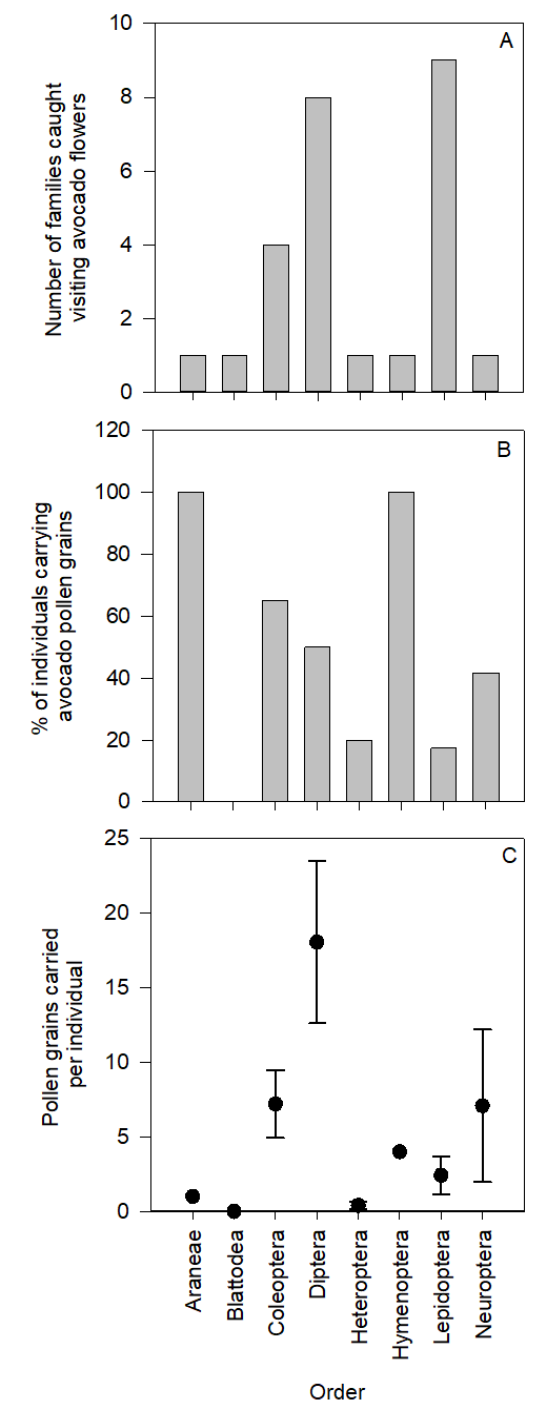
F IGURE 5: Summary of arthropod flower visitors caught while visiting open ‘Hass’ avocado flowers at night, showing the number of families of arthropods caught in each order (A), the percentage of individuals of each order that were found to be carrying avocado pollen grains (B), and the mean (+/-SEM) number of pollen grains found on each individual of each order